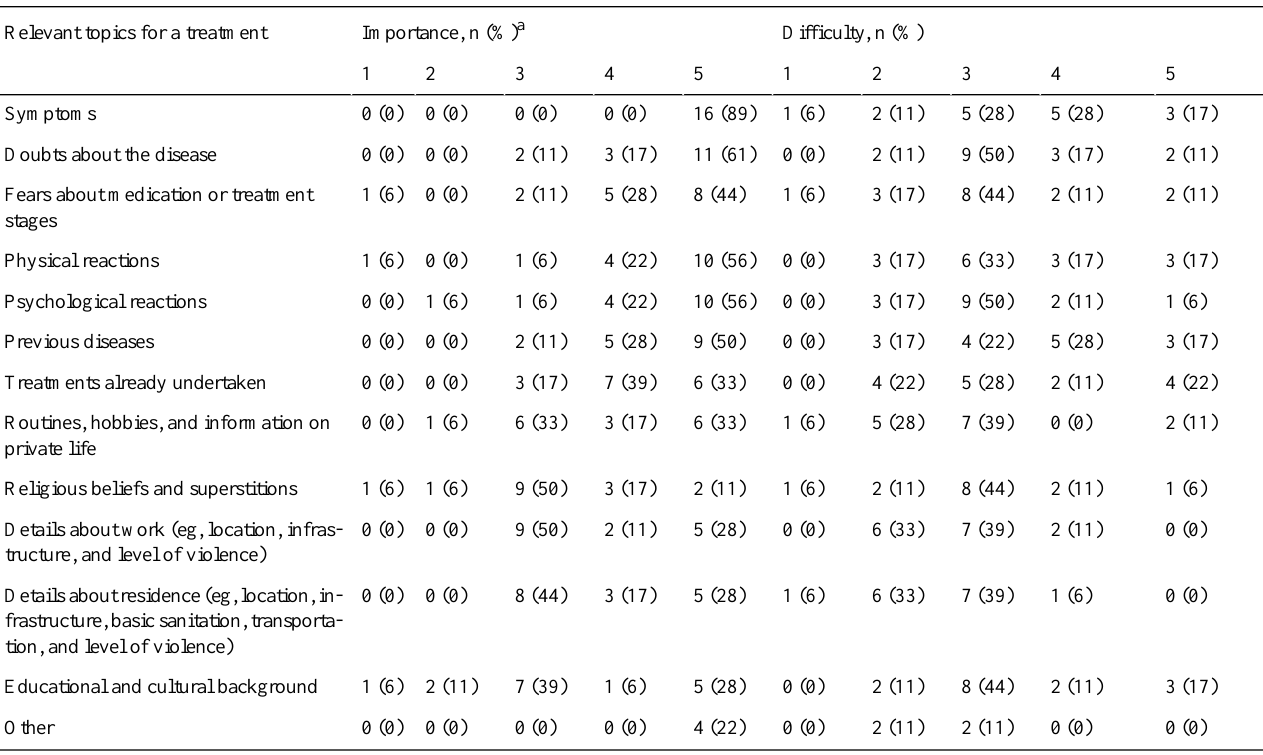
Table 6. Ratings of importance of information for a treatment and difficulty gathering information from patients (N=18).